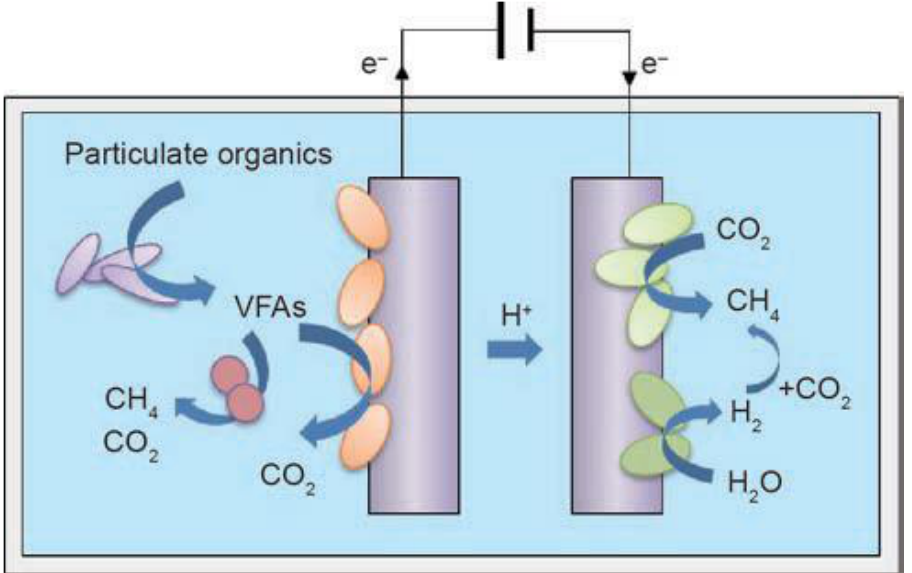
Figure 1. An illustration of bacterial interaction through the integrating effect of an MES and an anaerobic digestion process (VFAs: volatile fatty acids). Reproduced with permission [105].